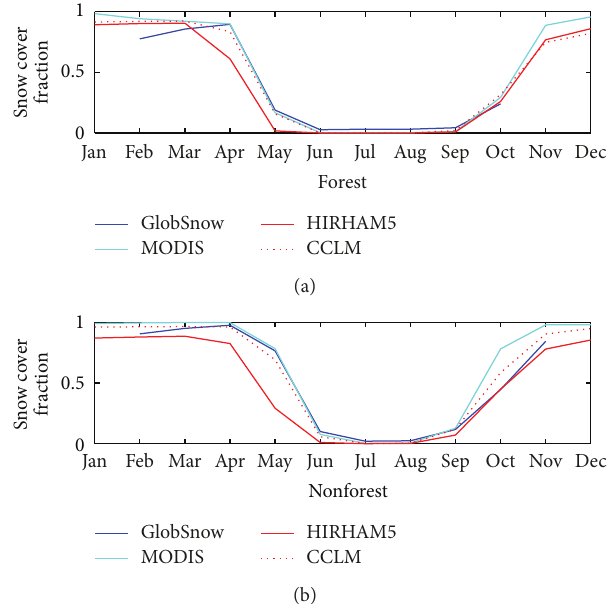
Figure 9: Annual cycle of snow cover fraction for Siberian subdomain derived from HIRHAM5, CCLM, MODIS and GlobSnow averaged over 2008 to 2010 for forest (a) and nonforest (b)